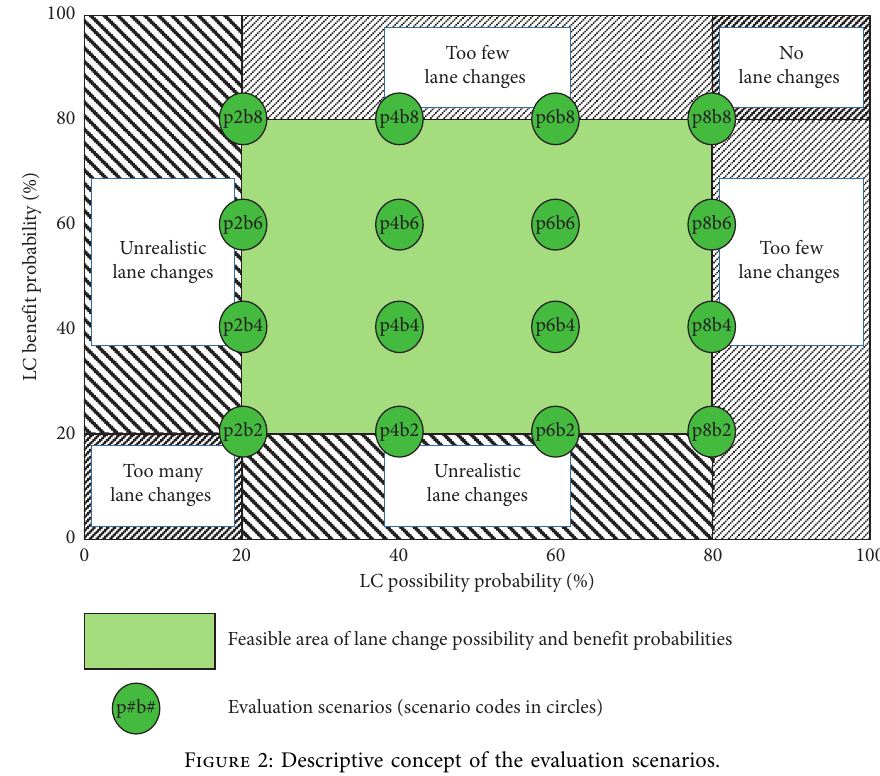
Figure 2: Descriptive concept of the evaluation scenarios.